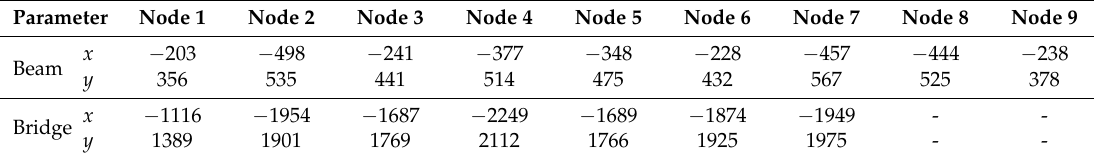
Table 5. The coefficients x and y calculated for all nodes of the beam and bridge for the no-damage condition.